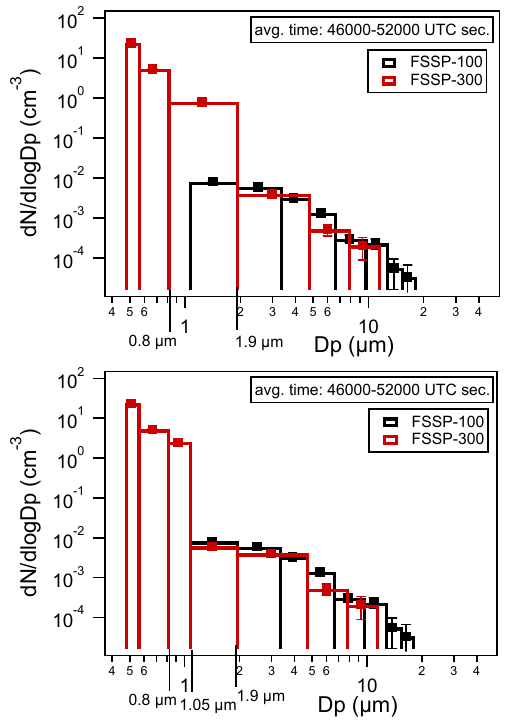
Figure 8. Size distributions of the FSSP-100 and FSSP-300 from a PSC encounter of 1.67h duration are compared for the complete PSC event during the first RECONCILE flight (17 January 2010). The sizing of particles between about 0.8 and 1.9µm is uncertain due to ambiguity in the Mie calibration curve. This is taken into account by the wide size bin, which consists of several instrumen- tal raw size bins. At the same time, the detected particle numbers exhibit a decrease of about 2 orders of magnitude over this size range. Assuming that most of the particles belong to the STS mode with spherical shape and sizes closer to the lower bin limit, the dis- crepancy of the FSSP-100 and FSSP-300 can be explained. This is shown in the lower panel, where the FSSP-300 size bin is divided by ignoring the ambiguity inherent in the Mie curve. The initially “suspected” apparent discrepancy between the two instruments in the overlapping bin can be understood this way.